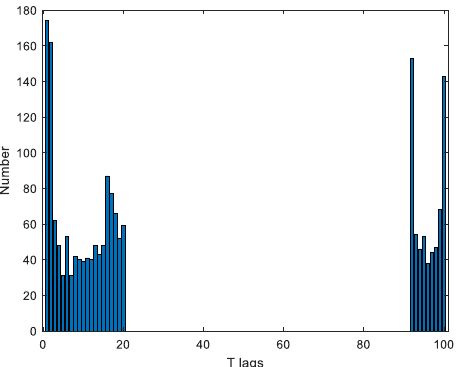
Figure 15. Histogram of the lags ’ usage in the non-dominated M 3 models.